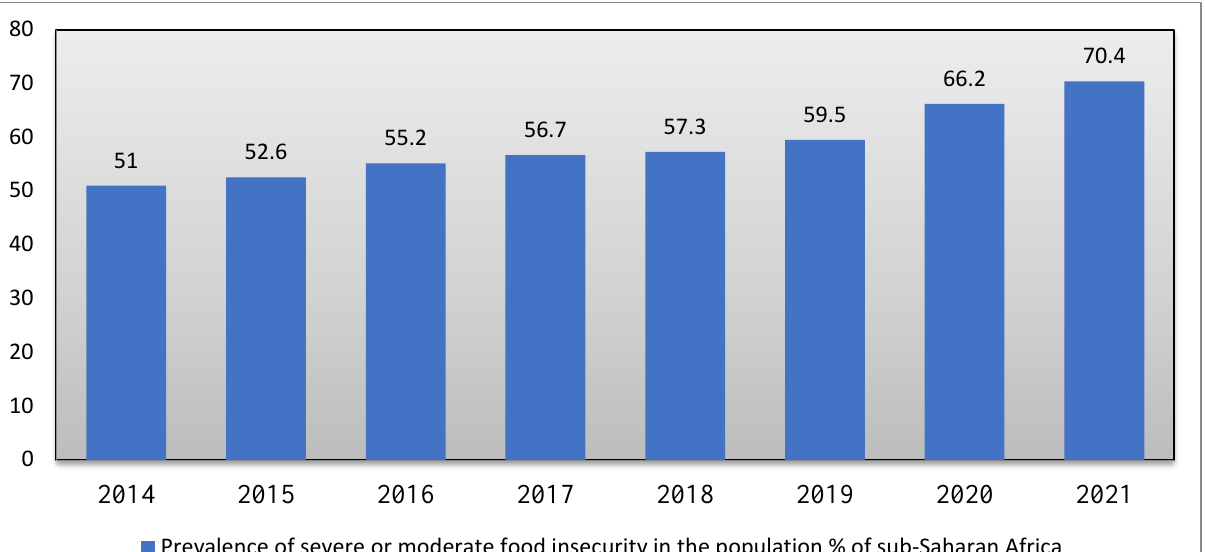
Figure 5. Prevalence of severe or moderate food insecurity in the percentage of the population of SSA. Source: https://data.worldbank.org/indicator/SN.ITK.MSFI.ZS?locations=ZG. Accessed on 12 June